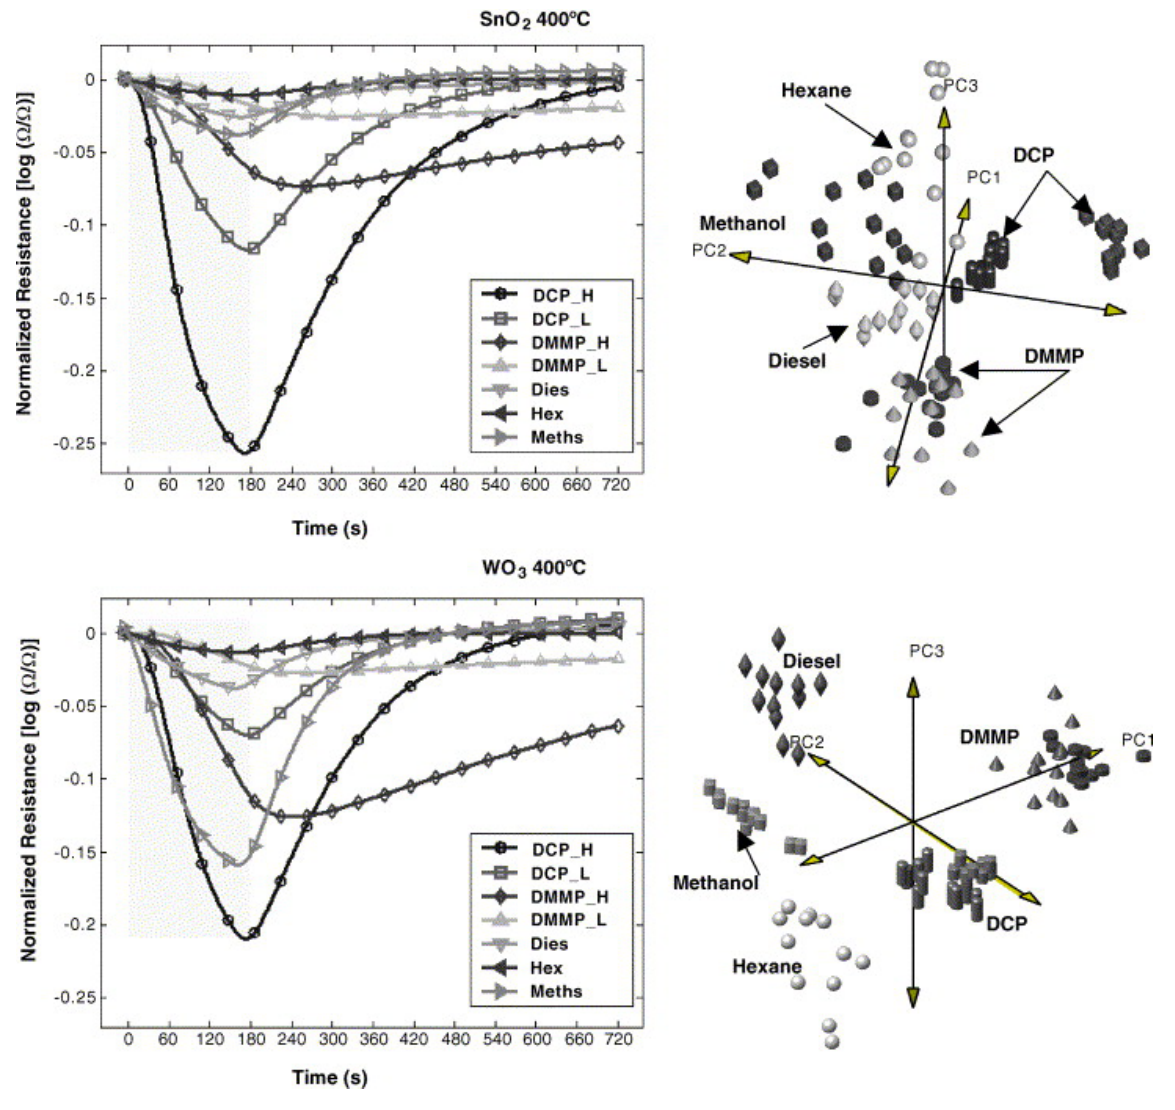
Figure 4. SMO sensors’ normalized responses to the gases of interest and corresponding LDA. (Reprinted from reference [13] with permission from